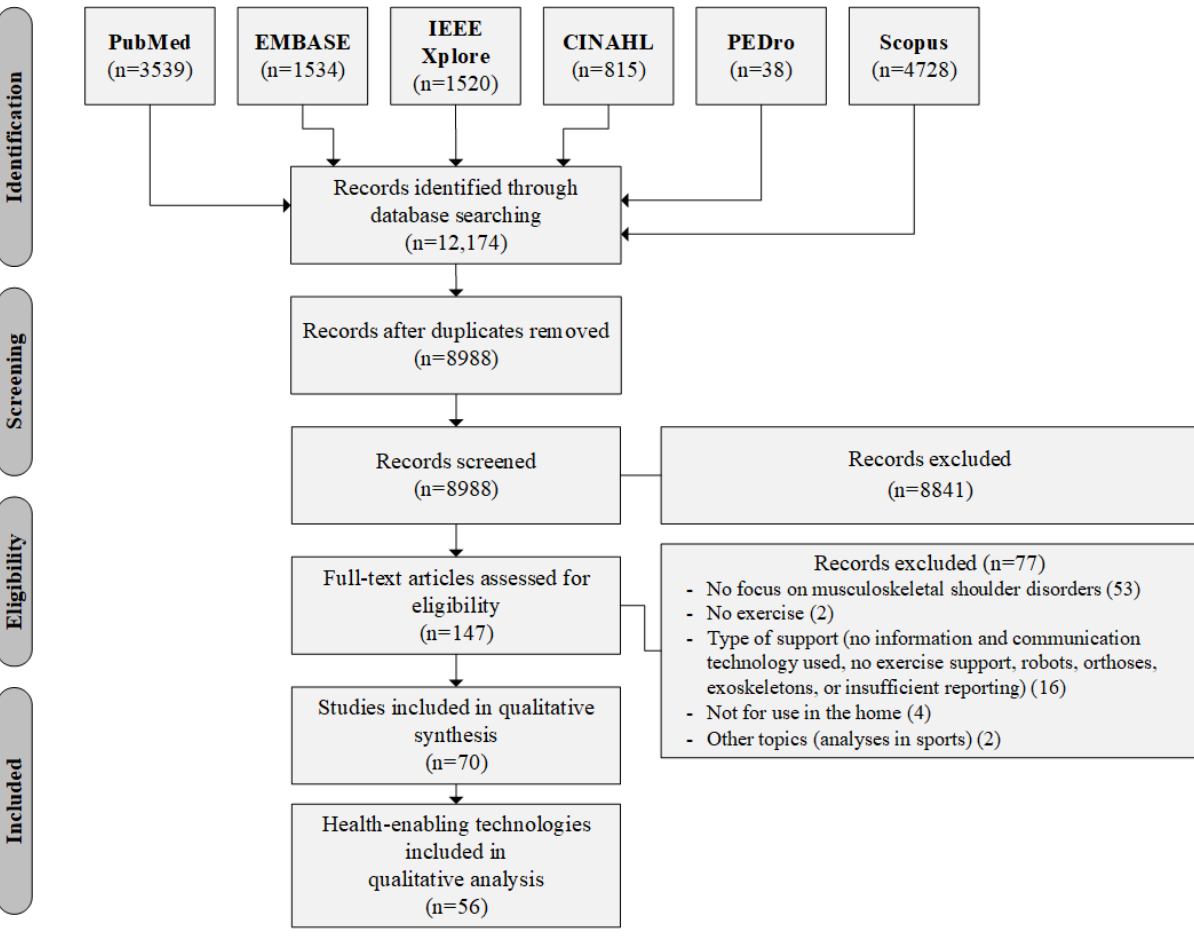
Figure 1. PRISMA (Preferred Reporting Items for Systematic Reviews and Meta-Analysis) flow diagram.